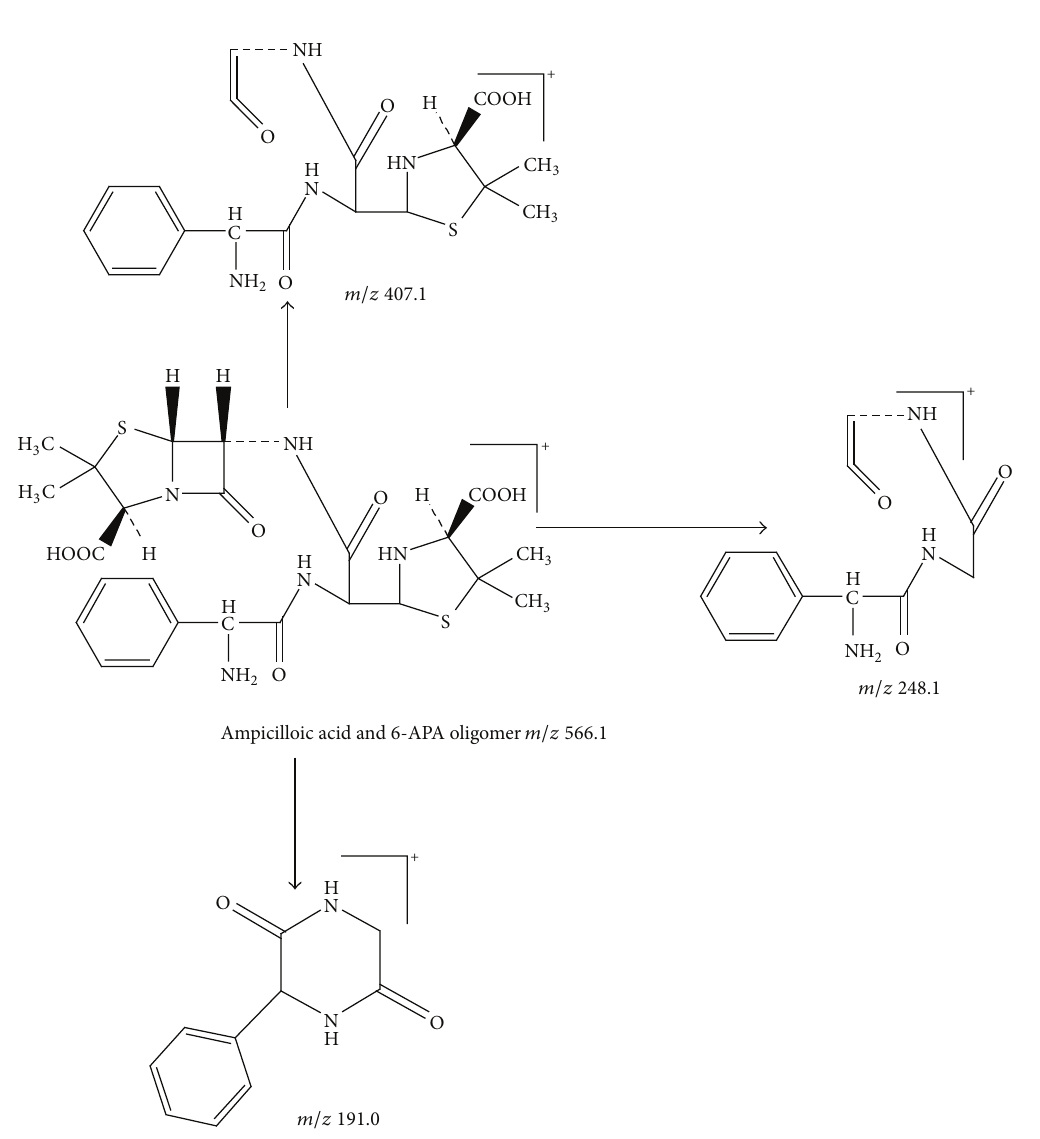
Figure 9: Proposed fragmentation pathway for the fragmentation ion of ampicilloic acid and 6-APA oligomer.